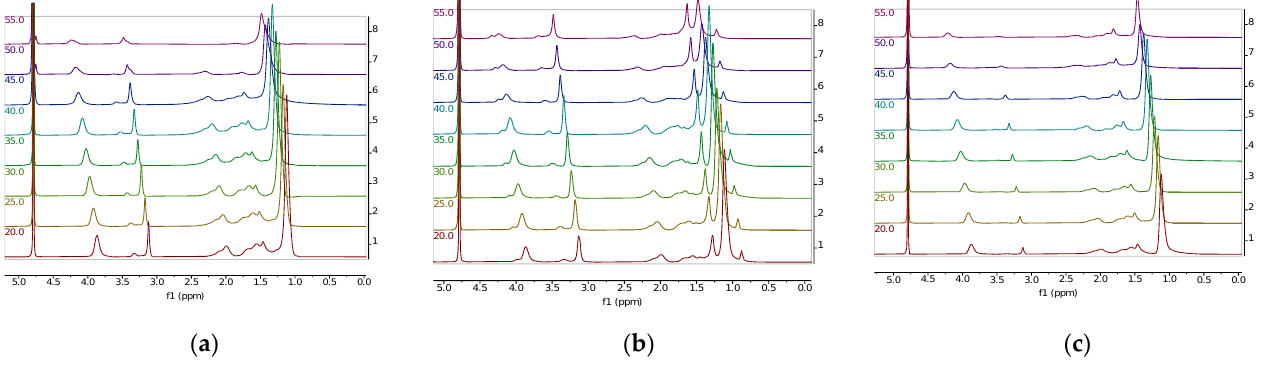
Figure 13. Temperature-variable 1 H NMR of NIPAM-APTAC-AMPS nanogels: ( a ) NIPAM 90 -APTAC 5 -AMPS 5 ; ( b ) NIPAM 90 -APTAC 7.5 -AMPS 2.5 ; ( c ) NIPAM 90 -APTAC 2.5 -AMPS 7.5 .